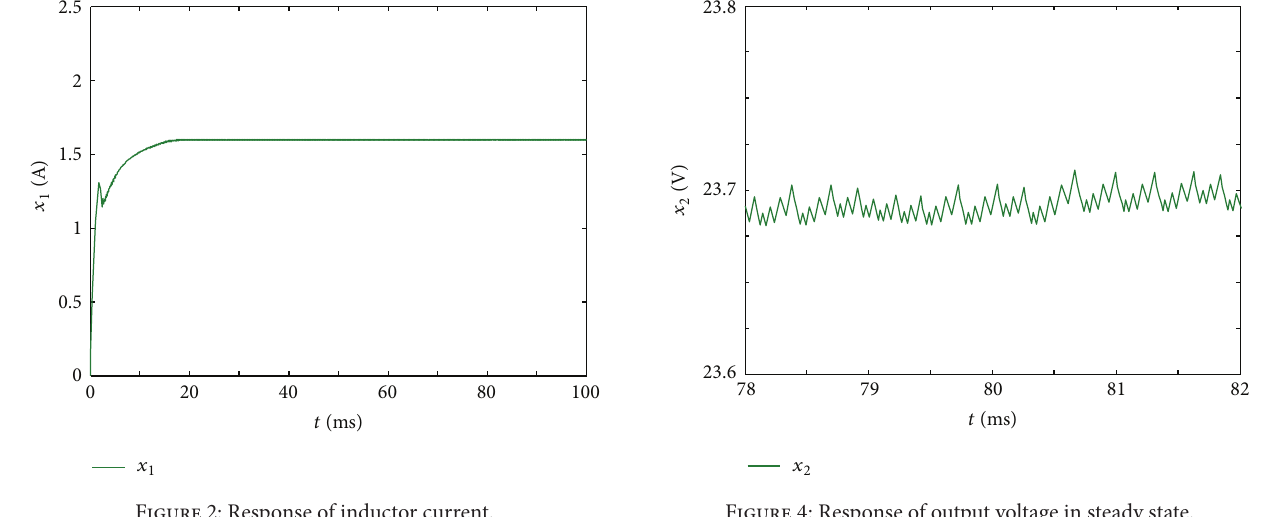
Figure 2: Response of inductor current.